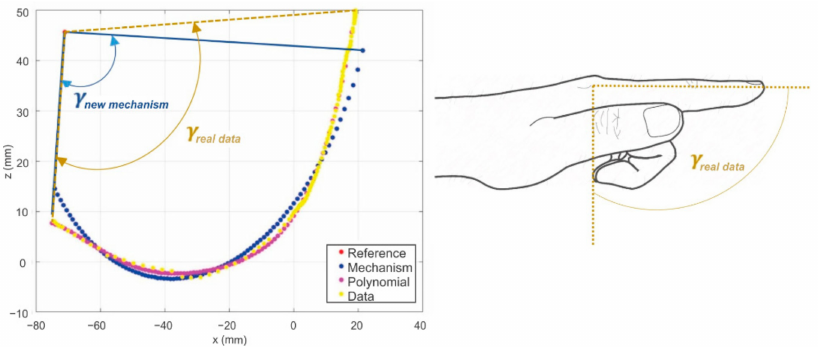
Figure 22. Angles of the amplitude of the